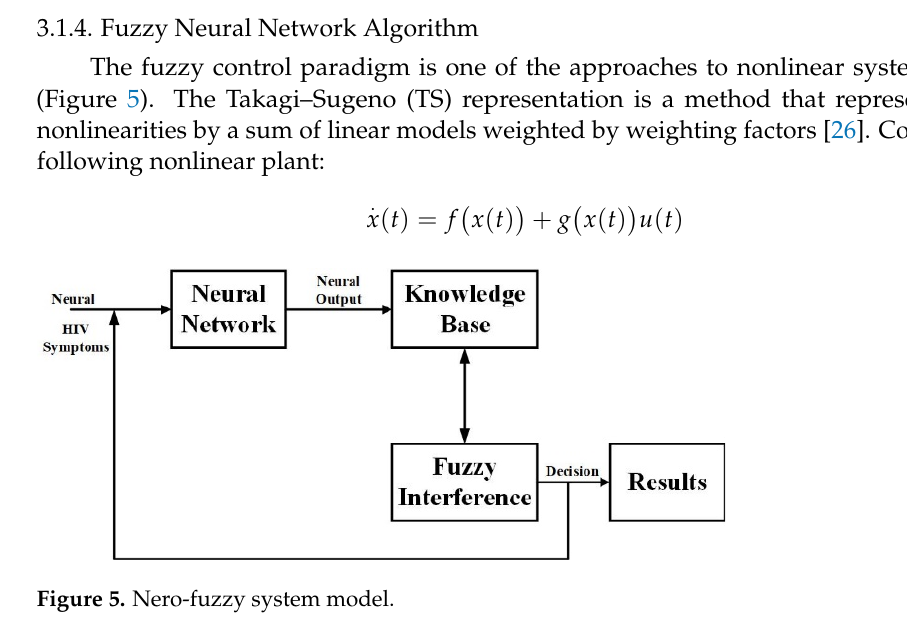
Figure 4. Active fault-tolerant controller applied on the autonomous vehicle.